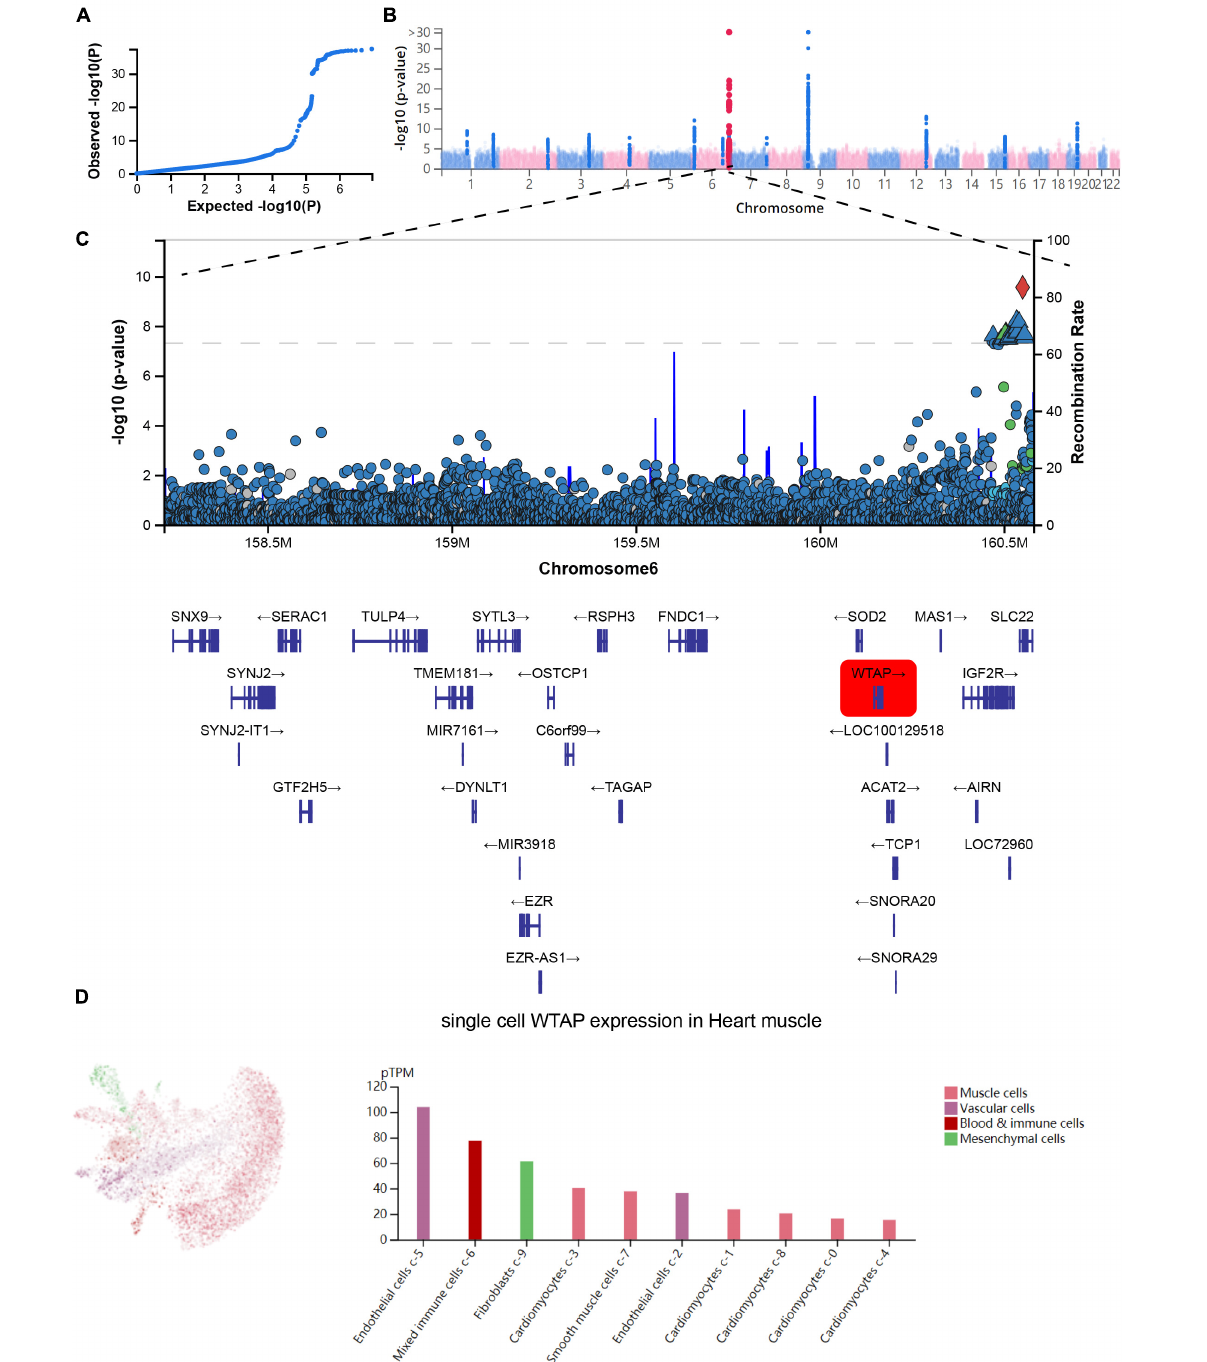
regulators, we explored the correlation among 15 m6A RNA methylation regulators. FTO, YTHDF1, IGF2BP3, RBM15B, YTHDF3, IGF2BP2, and RBM15 were mostly upregulated in